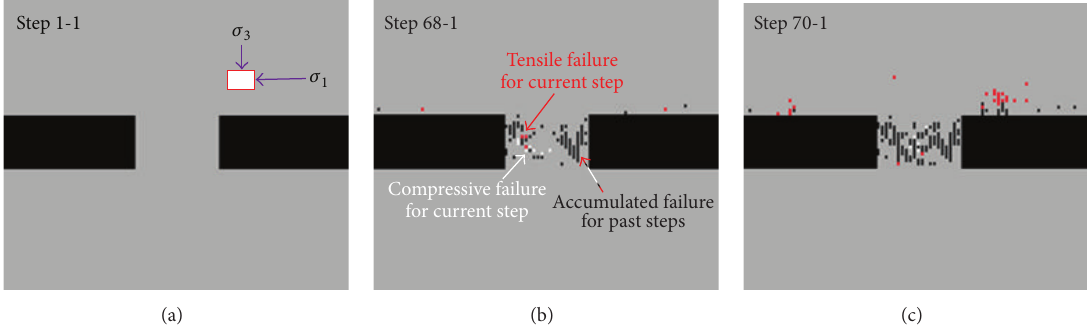
Figure 11: Plot of acoustic emissions for a pillar with width-to-height ratio = 1.5.